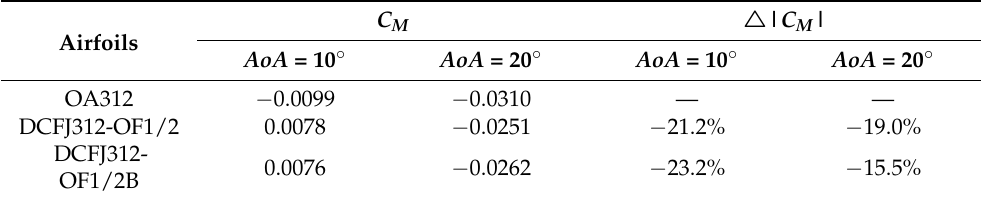
Table 14. Comparisons of moment coefficients of DCFJ312 airfoils with various RUL s at typical AoA